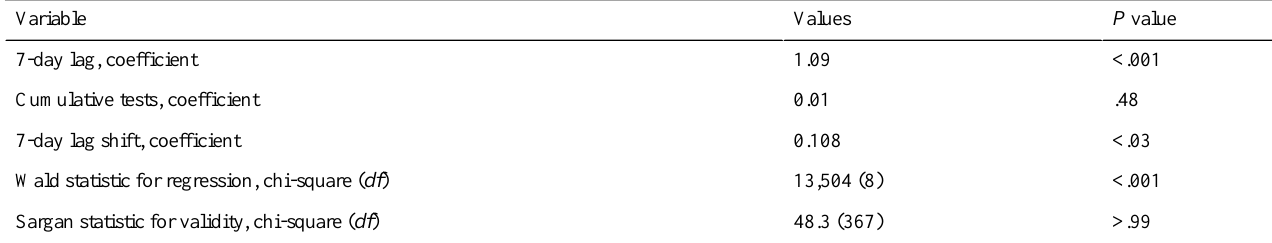
Table 1. Arellano-Bond dynamic panel data model of COVID-19 dynamics at the state level.